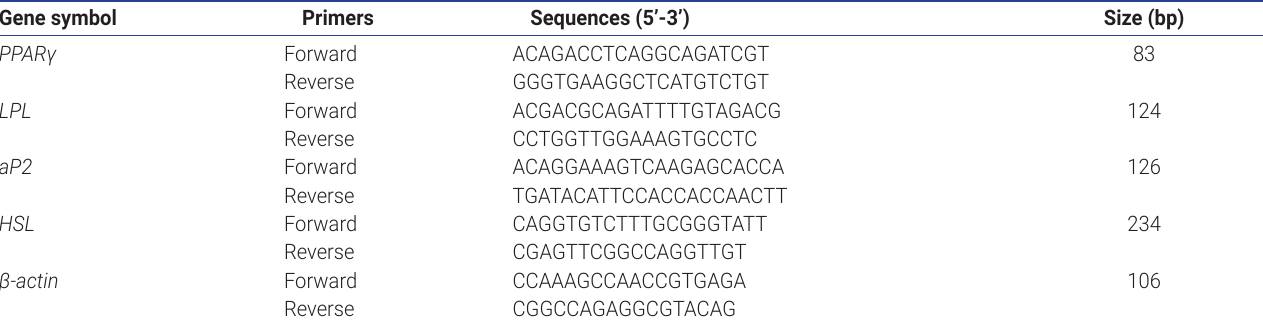
Table 3. Primers used for real-time polymerase chain reaction